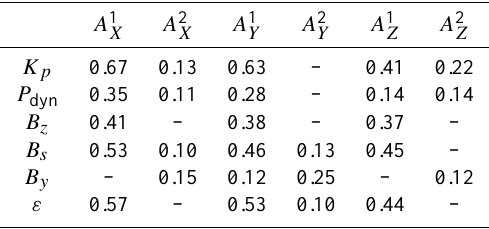
Table 1. The Pearson’s | r | linear coefficient. The “–“ refers to values less than the fixed threshold value | r s |